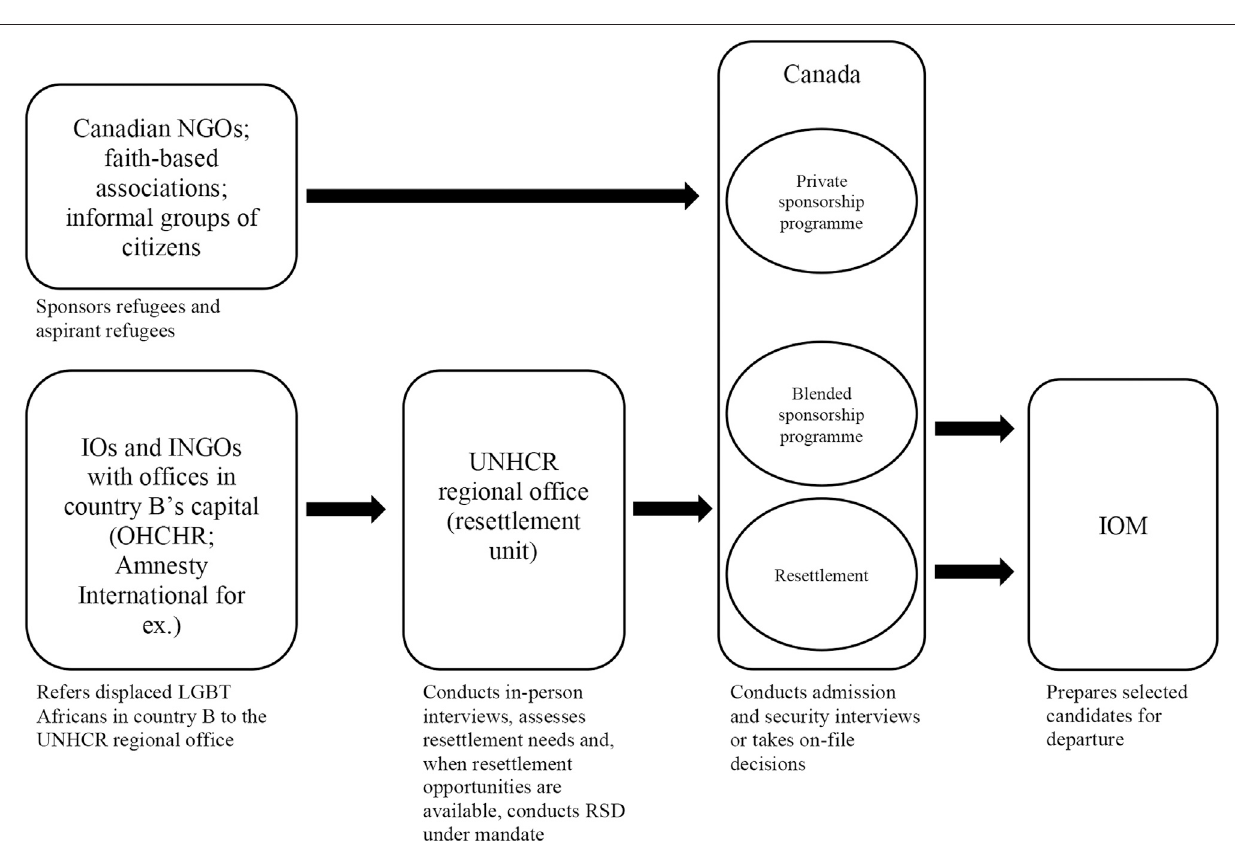
Frontiers in Human Dynamics |